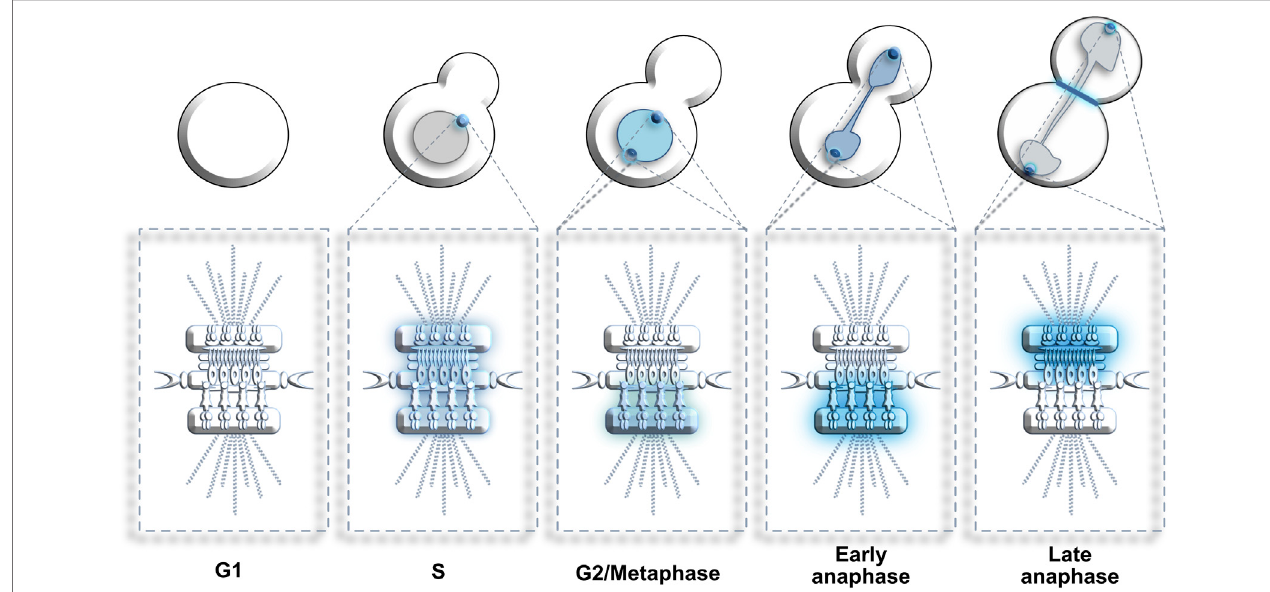
FIGURE 4 | Dynamic localization of Cdc5/Polo kinase at SPBs. G1: Cdc5 is absent from cells. S: Cdc5 enriches at the non-duplicated SPB. G2 to metaphase: Cdc5 decorates the nucleus and the nuclear surface of both SPBs. Early anaphase: Cdc5 concentration at the nuclear surface of both SPBs increases. Late anaphase: Cdc5relocatesfromtheinnertotheoutersurfaceofbothSPBs(andbudneck)whereitstimulatesmitoticexit.BluecolorrepresentsenrichmentofCdc5.Colorintensity represents Cdc5 concentration levels.